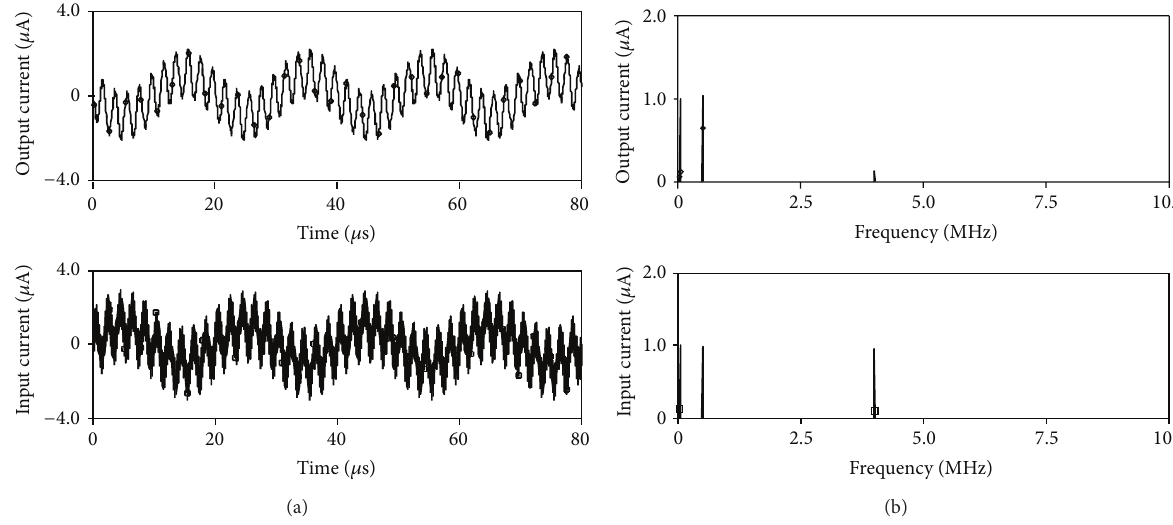
12(a) and 12(b). It is clear that the 50 KHz, and 500 KHz signals are passed without attenuated and 4 MHz signal is significantly